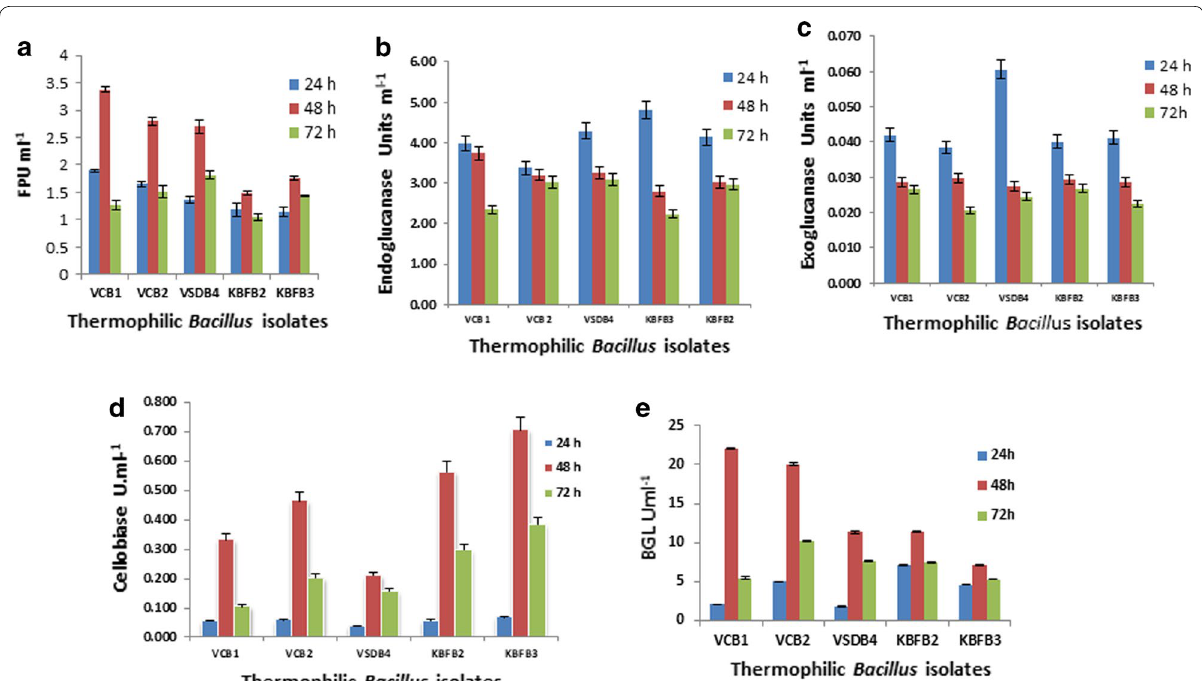
Fig. 5 Cellulase activity profile by the bacterial isolates on different substrates. The bacterial isolates were grown on their respective production media with CMC, Avicel and cellobiose. Enzyme activity was assayed by incubating the crude enzyme with various substrates a filter paper; b CMC;